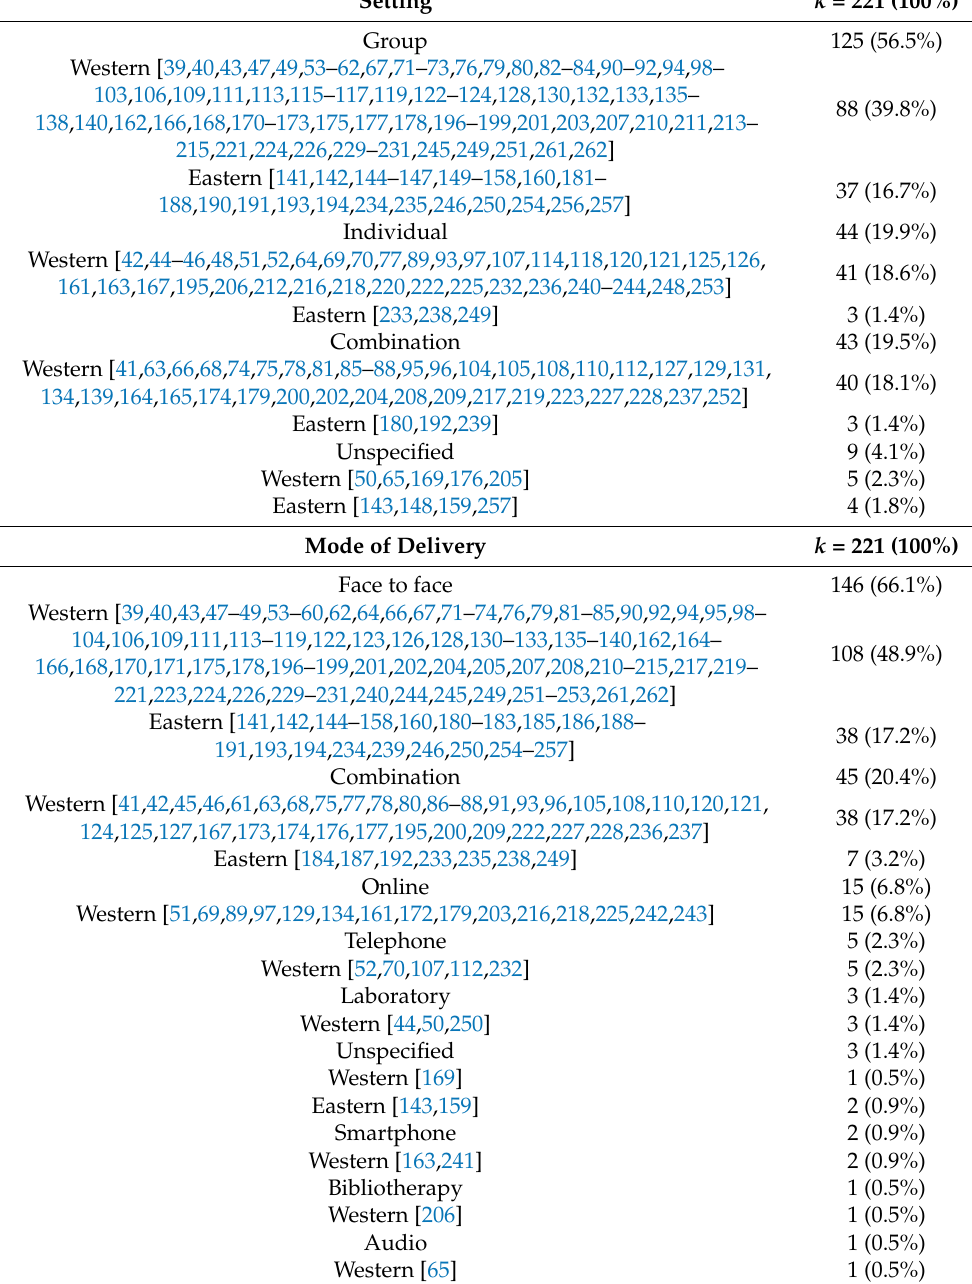
Table 2. Summary of the intervention characteristics and control group designs of the included